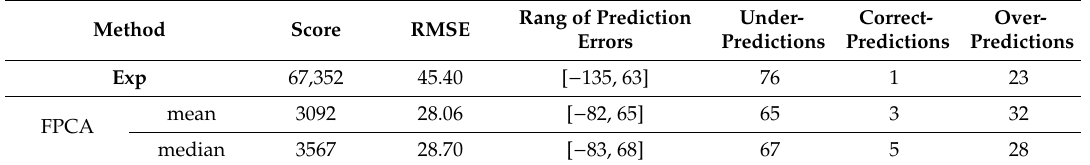
Table 6. Comparison of RUL prediction results for the 100 testing